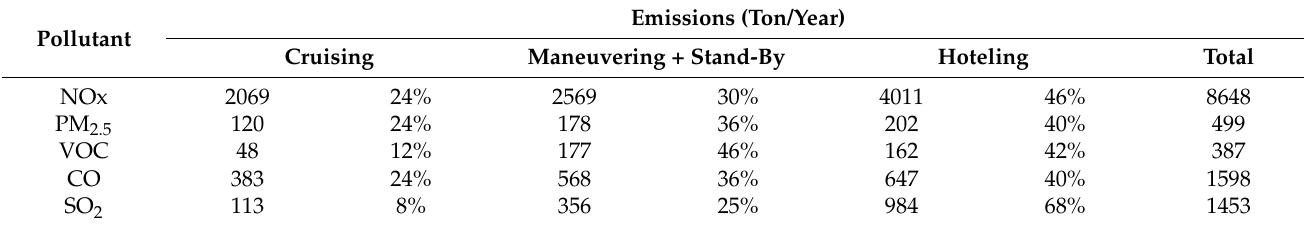
Table A11. Total emissions from vessels (Haifa, MPS A1 2025).